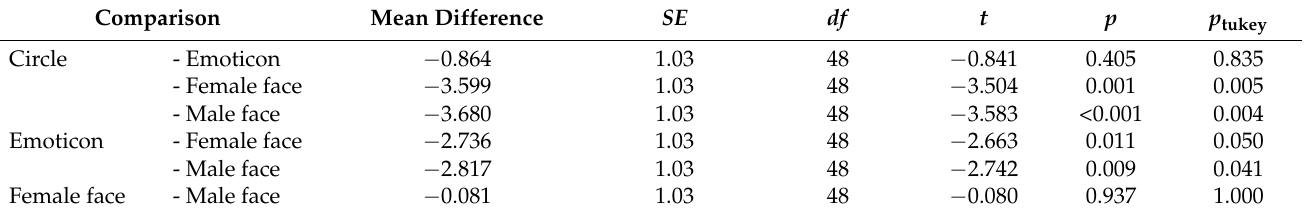
Table 1. Results of post hoc comparisons. Significant differences are revealed between human face stimuli and geometric pattern